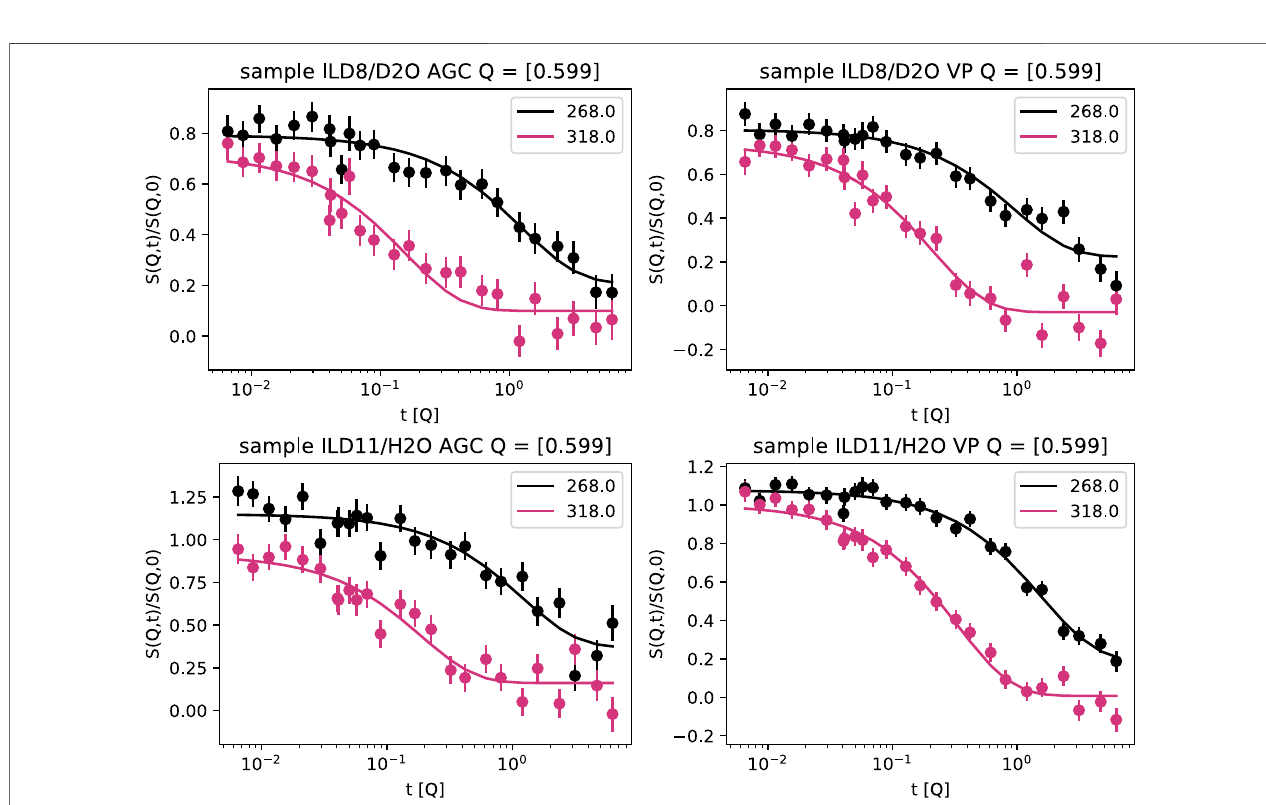
FIGURE5 | Normalised intermediate scattering function S(Q, t)/S(Q, |0) at Q= | 0.6 Å − 1 and twotemperatures (265 K, 318 K) for ILD8/D2O (top) and ILD11/H2O (bottom) con fi ned in AGC (left) and VP (right).